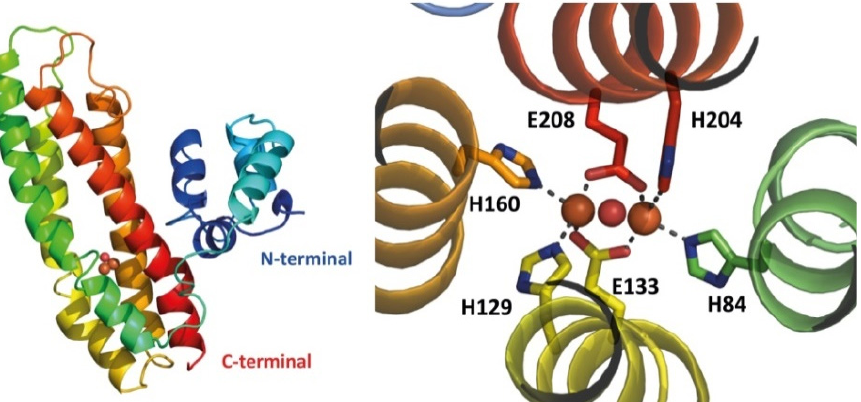
Figure 2. Structure of E. coli YtfE. The left panel shows a carton diagram of the YtfE monomer, rainbow-colored from the N-terminal (in dark blue) to the C-terminal (in red). The right panel displays a close-up view of the di-iron site, with the protein backbone shown in cartoon representation and the ligand residues depicted as sticks, with the iron atoms represented as orange spheres and the oxygen in the oxo-bridge as a red sphere (PDB entry 7BHA).